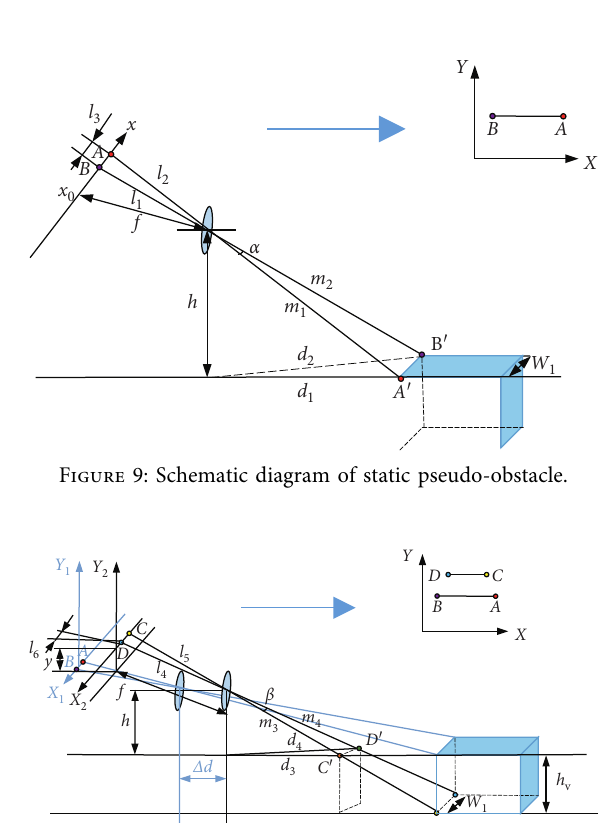
Figure 8: Schematic diagram of static pseudo-obstacles after the ego-vehicle moved.